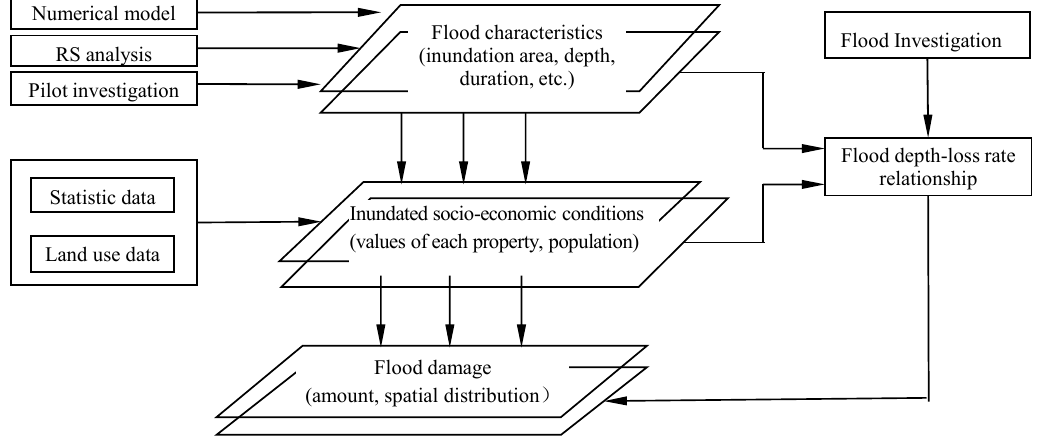
Figure 4. The flow chart of flood damage assessment.